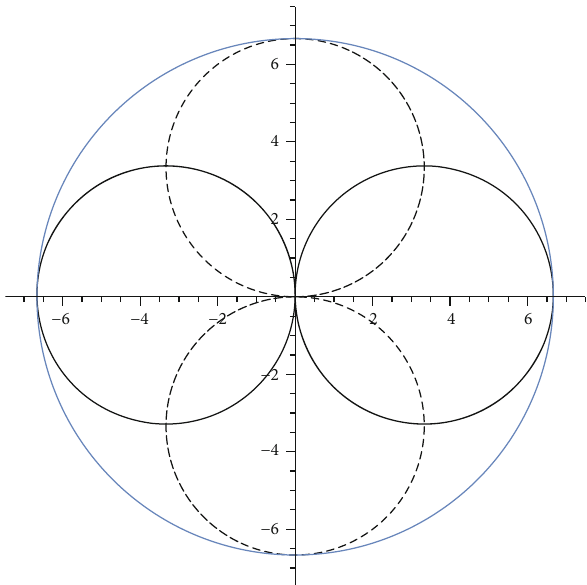
= 0 and α = 0 : 3 . o z . The o = +1 (solid black on the y = 0 with v xo y